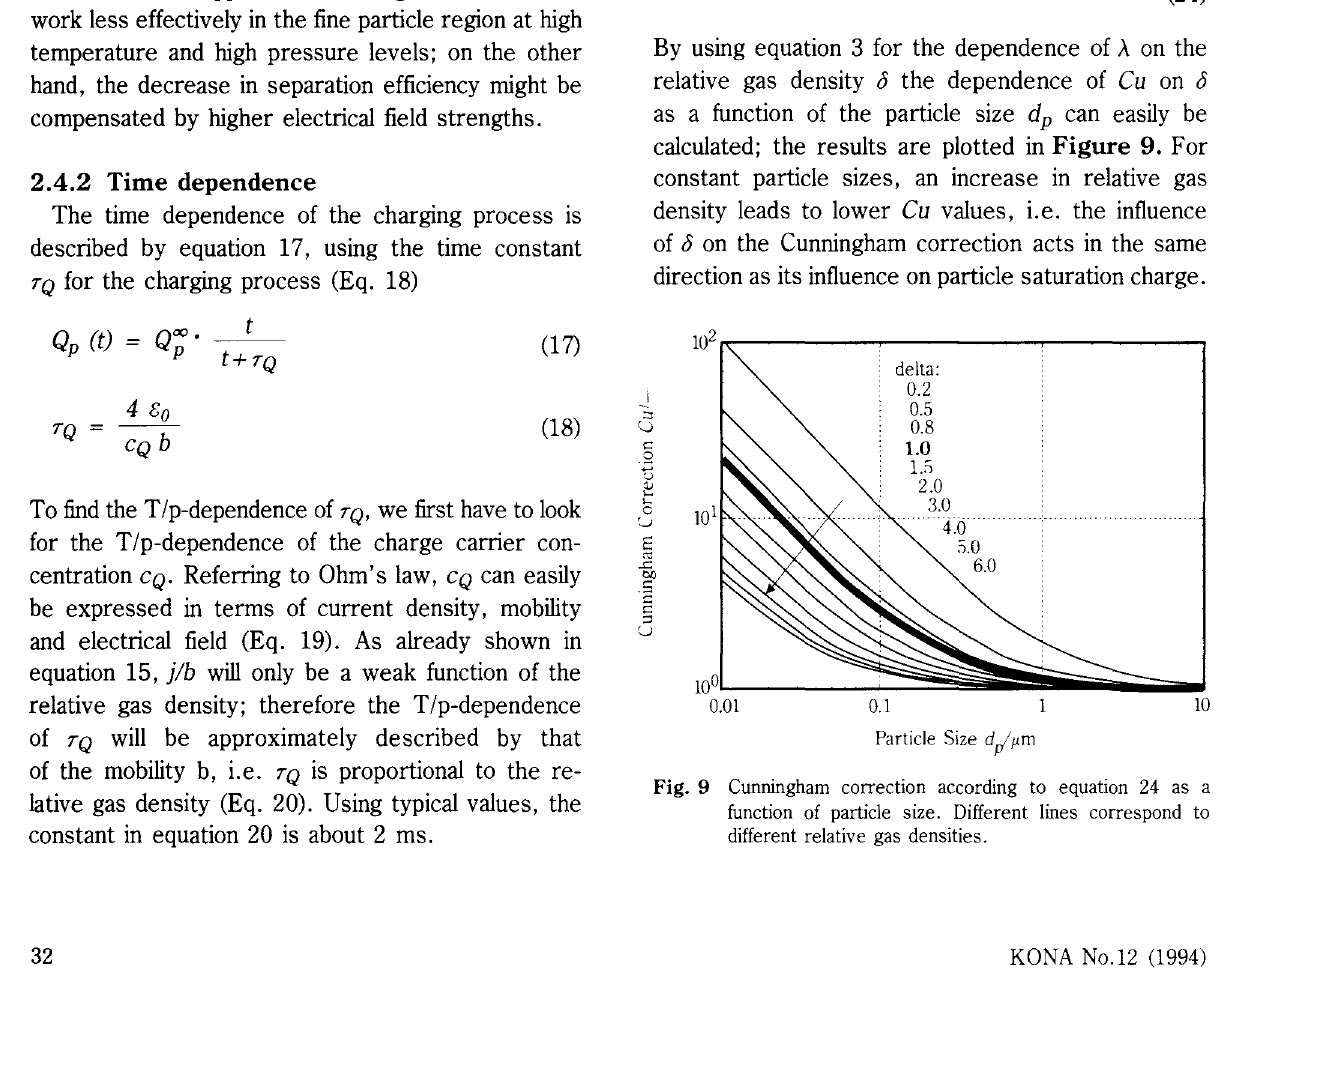
Fig. 8 Particle saturation charge according to Cochet S) plotted over particle diameter. An electrical field strength of 3.0 kV/cm and a relative electrical permittivity of 10 is assumed for the calculations. Different lines correspond to different relative gas densities.